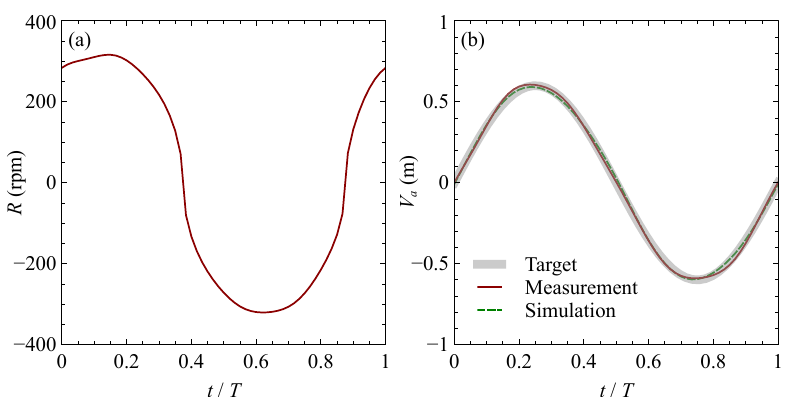
Figure 6. ( a ) Time series of rotational speed. ( b ) Time series of velocity using O-tube